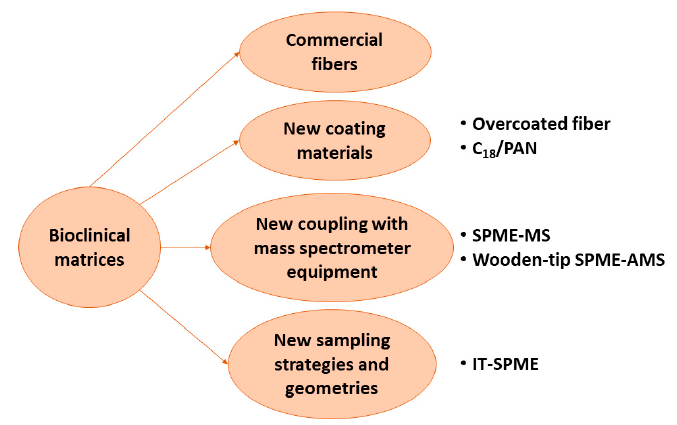
Figure 6. Main solid-phase microextraction geometries and strategies used in the analysis of bio-clinical matrices during the covered period (2014–2019).